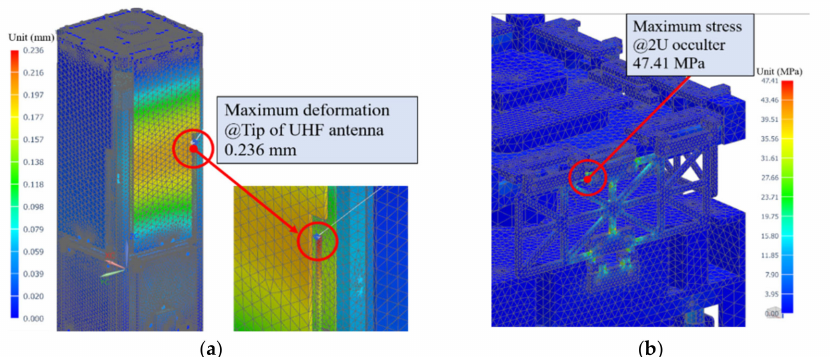
Figure 7. Quasi-static acceleration analysis results: ( a ) maximum deformation in X-axis; ( b ) maximum stress in Y-axis.